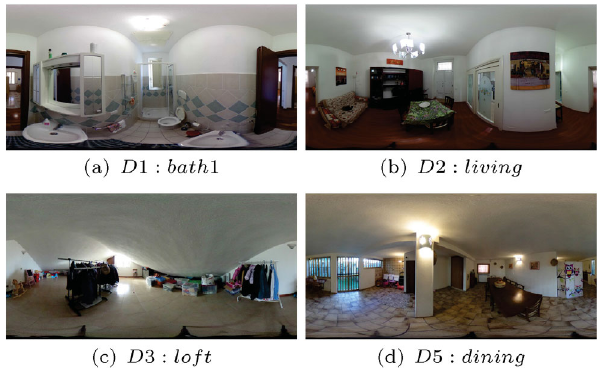
Captured panoramic images. We have captured many cases with textureless walls and ceilings, as well as moderately to heavily cluttered environments. Such clutter is not evident in the reconstructed 3D models, which include only the geometric boundary data and not the removed